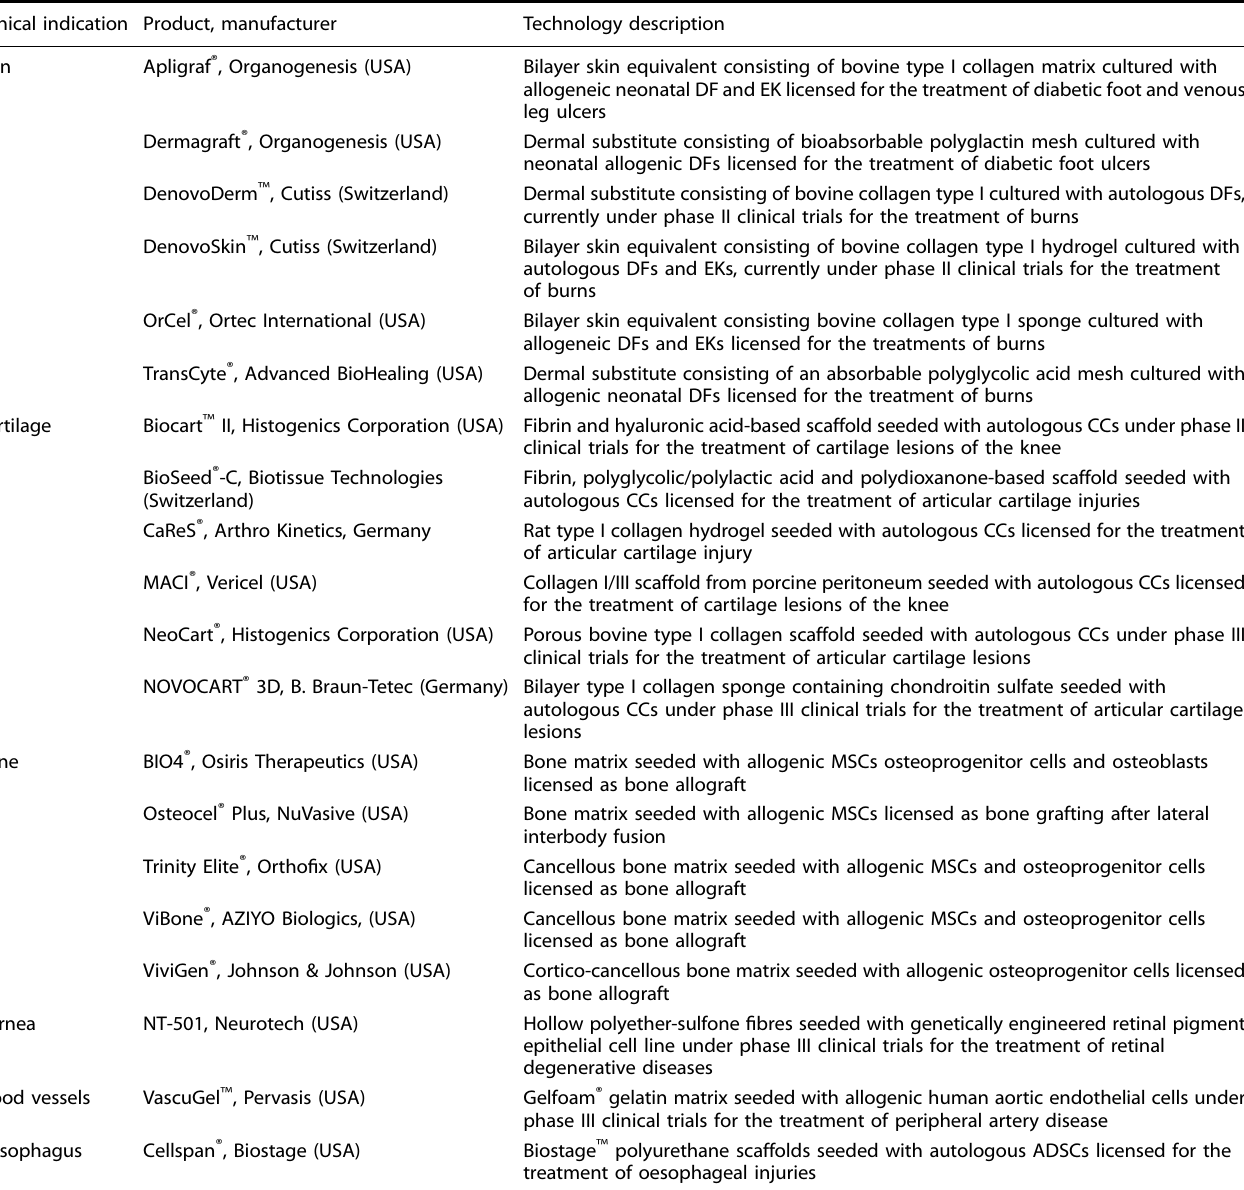
Table 1. Commercially available scaffold-based cell systems. Clinical indication Product,